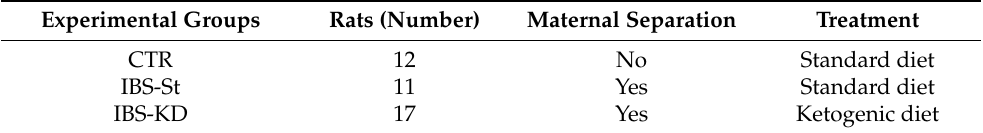
Table 1. Experimental groups: no irritable bowel syndrome (IBS) rats fed a standard diet (control group, CTR); IBS rats fed a standard diet (IBS-St); IBS rats treated with low-carbohydrate, high-fat ketogenic diet